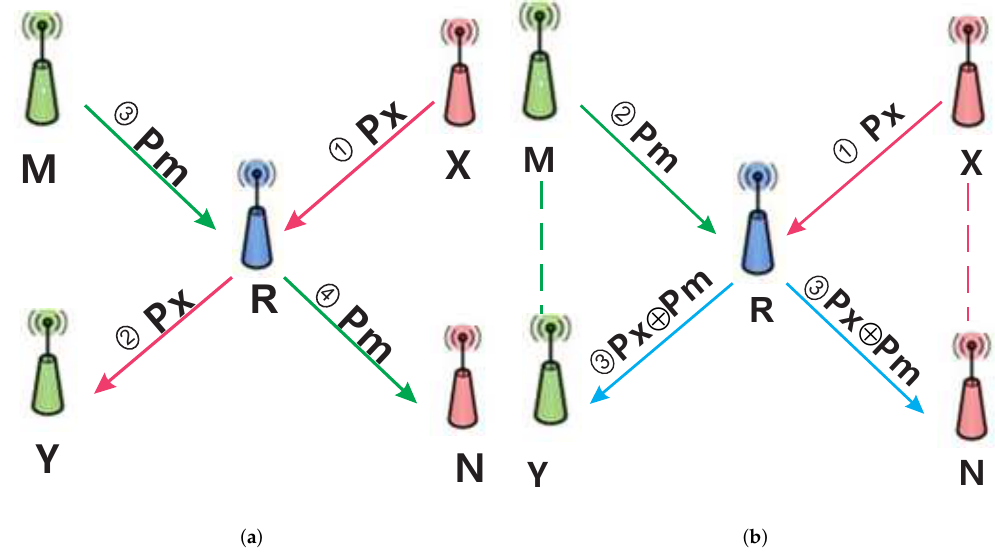
Figure 1. Illustration of “X structure” network coding. ( a ) Transmission without network coding; ( b ) Transmission with network